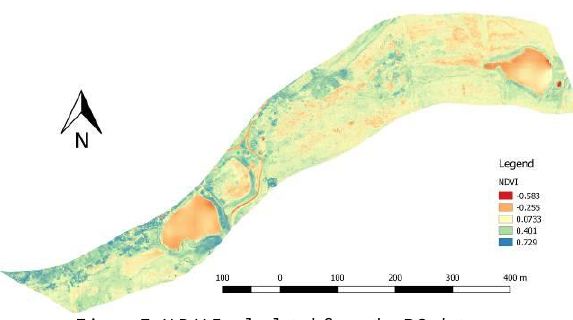
Figure 6. NDVI calculated from the PD dataset.